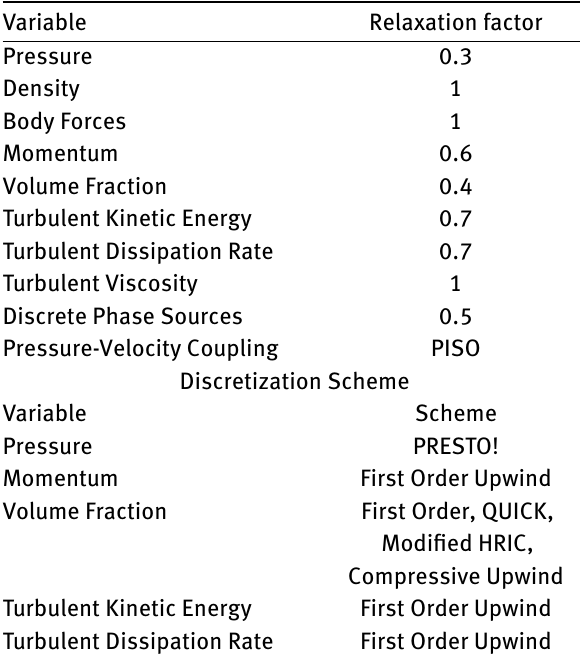
Fig. 4: The experimental rig